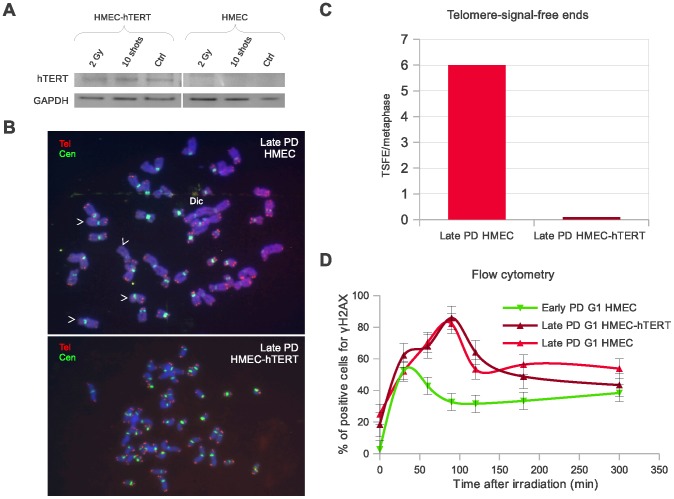
Restoration of telomerase activity in the late PD HMEC samples does not rescue their delayed DSB disappearance phenotype.Results obtained from donor 1 samples. A. Western blot showing that transduction of late PD HMECs with hTERT gene restituted telomerase protein subunit expression. B. Metaphase plates of a late PD non-transduced (top) and hTERT-transduced (bottom) HMECs. Telomeric (red) and centromeric (green) sequences detected with fluorescent in situ hybridization procedures. Telomerase restoration resulted in a reduction of telomere-signal-free ends (white arrow heads) and end-to-end fusions (Dic) as a consequence of telomere elongation. C. Bar diagram showing average frequencies of telomere-signal-free ends in non-transduced and hTERT-transduced HMECs. D. Histogram showing the kinetics of γH2AX appearance and disappearance measured by flow cytometric analysis. hTERT-transduced late PD HMECs (brown) reach its maximum percentage of γH2AX positive cells 90 min post-irradiation, which is delayed as compared to the early PD HMECs (green), but is the same time point as non-transduced late PD HMECs (red). A minimum of 10,000 cells and two replicas were analyzed by bivariate flow cytometry for each time-point and cell subpopulation.